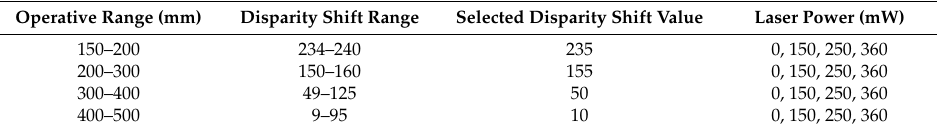
Table 5. The tested value of disparity shift and laser power for each